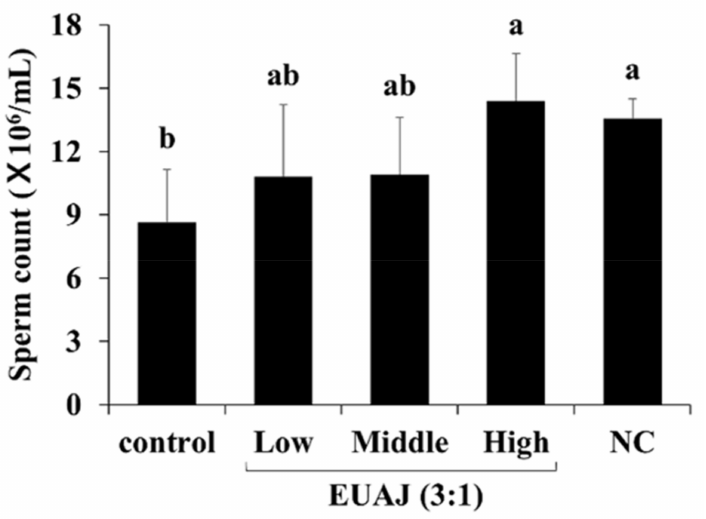
Figure 4. The effects of EUAJ (3:1) on sperm count in SD rats. Values are presented as means ± SD. Different superscript letters show a significantly difference at p < 0.05 as determined by Duncan’s multiple range test. Control; saline, low; EUAJ (3:1) 20 mg/kg, middle; EUAJ (3:1) 40 mg/kg, high; EUAJ (3:1) 80 mg/kg, NC;